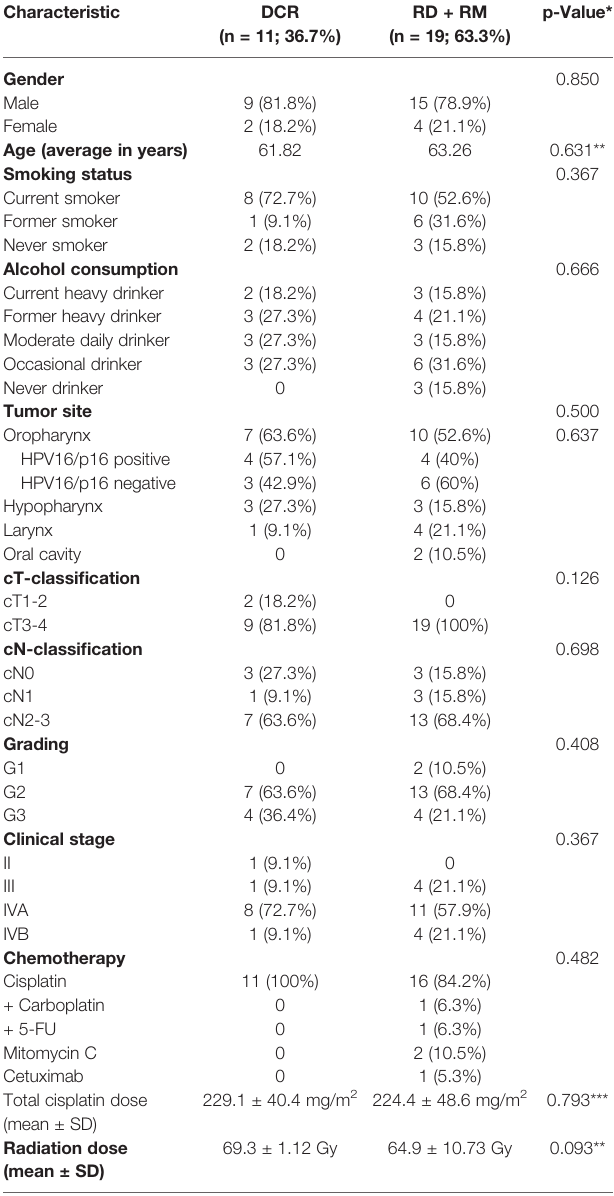
TABLE 1 | Patient characteristics at initial diagnosis and treatment parameters.